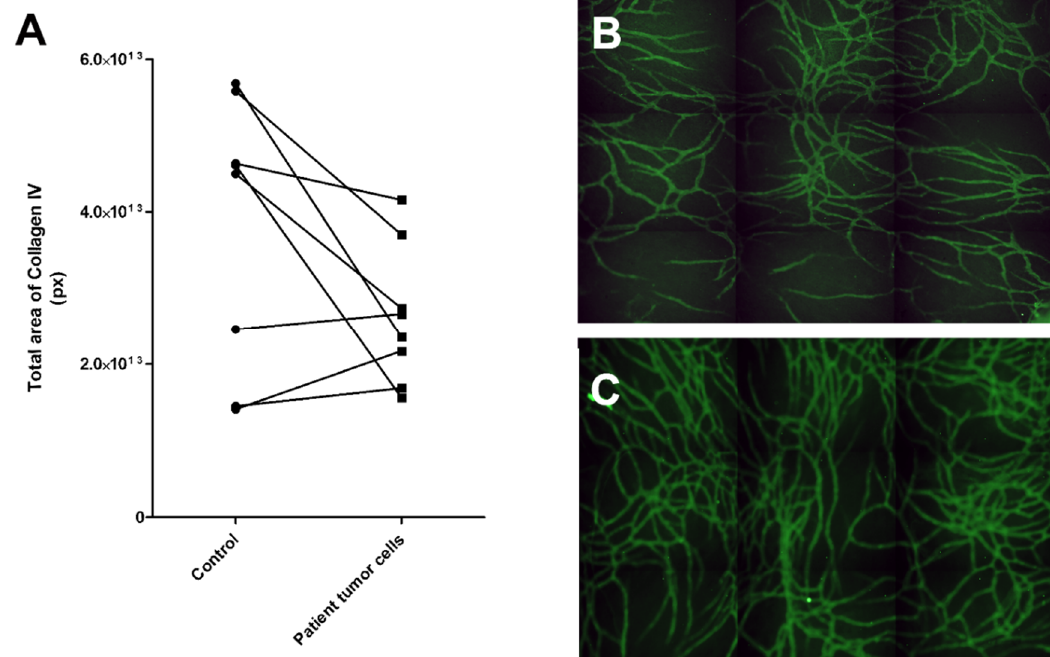
Figure 6. Testing of patient-derived cancer cells in the angiogenic potential assay. ( A ) Results of eight patient samples tested for their angiogenesis-induction potential. Three of the samples showed an increase in angiogenesis compared to the control, i.e., vasculature cells grown without patient sample cells. ( B ) Control vasculature without cancer cells had less vascular structures than ( C ) vasculature with patient sample 6. Control vasculature was cultured in the same medium as the experimental culture. The vasculature was stained with anti-collagen IV (FITC, green). Both B and C were obtained with automated imaging system (Cell-IQ) by imaging 3 x 3 grid with 10x objective and stitching these together to create a larger view of the well. Table 2. Characteristics of the samples received from patients and results obtained from the angiogenic-induction potential test. Those samples which differ only mildly from control are marked in parenthesis.